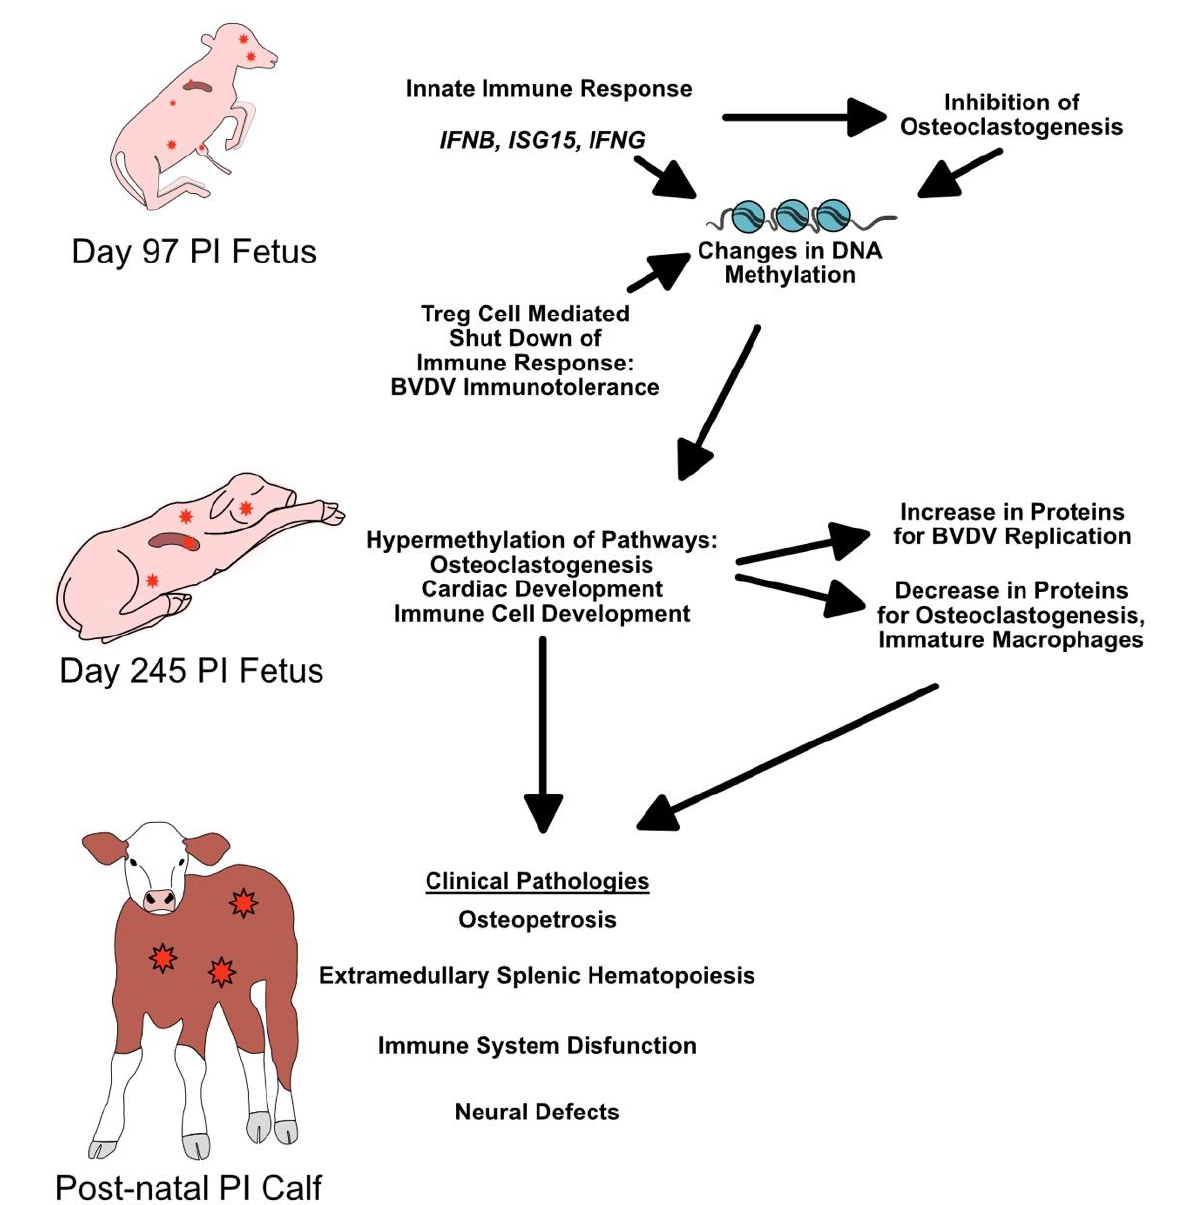
Figure 4. Hypothesized changes in prenatal PI calves in response to BVDV fetal infection and its effects on postnatal calf pathologies. Red stars = BVDV antigen. Day 97 data from Georges et al. 2020 and Smirnova et al. 2012.